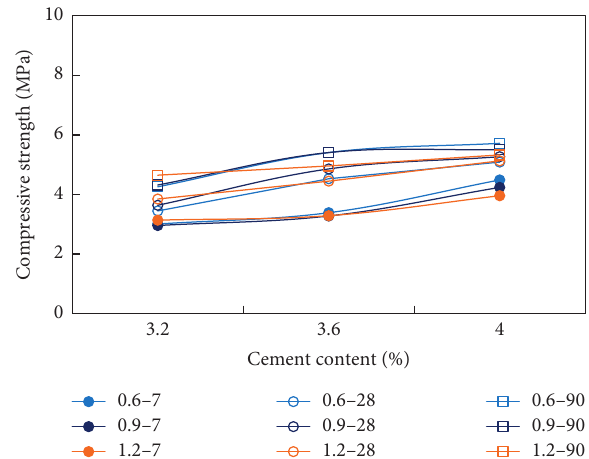
Figure 13: Trend chart of UCS of CSM with different